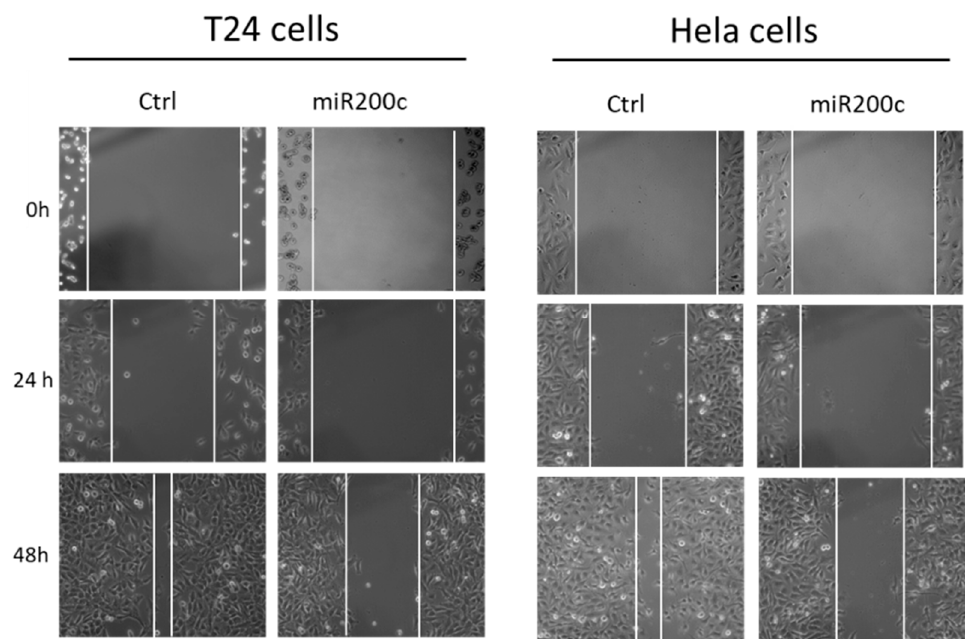
Figure 7. Inhibition of tumor cell migration. Images of a scratch assay of T24 and HeLa cells. Cells were treated with MSN160 nm-454-GE11 loaded with miR200c. The cell layer was broken after 24 h through a scratch and the closure was monitored for 48 h.